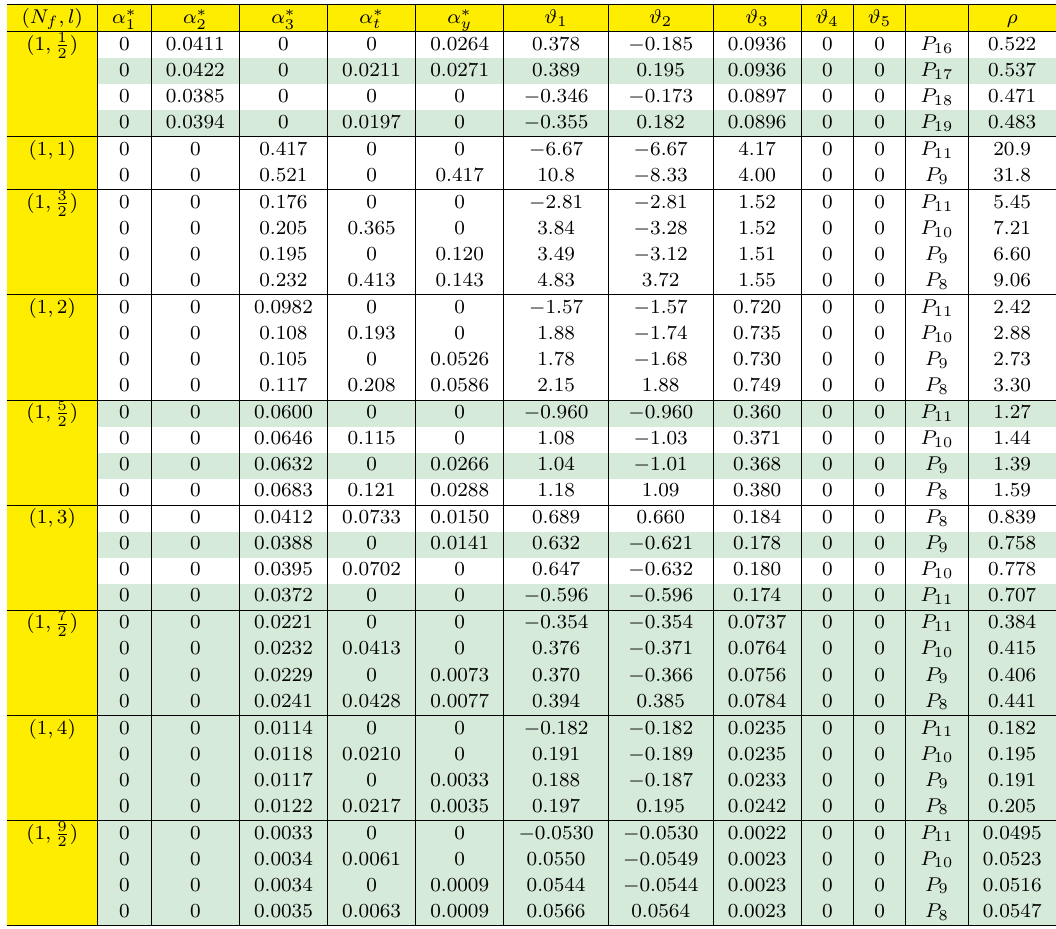
Table 5 . Fixed points and eigenvalues for vector-like fermions in the fundamental representation of SU c (3), in the 210 approximation scheme, with N f = 1. We highlight in green the (cid:12)xed points that appear also in the 321 approximation scheme. The labels in the second to the last last column refer to the list in table 12. The last column gives the values of the ratio (cid:26) for (cid:11) on the case (see 2.15).